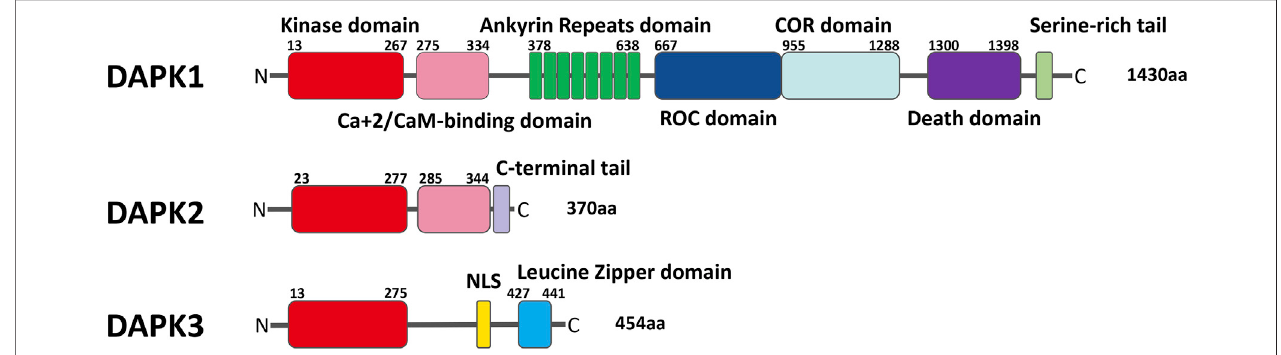
FIGURE 1 | Schematic representation of the domains of each of the DAPK family members with their respective